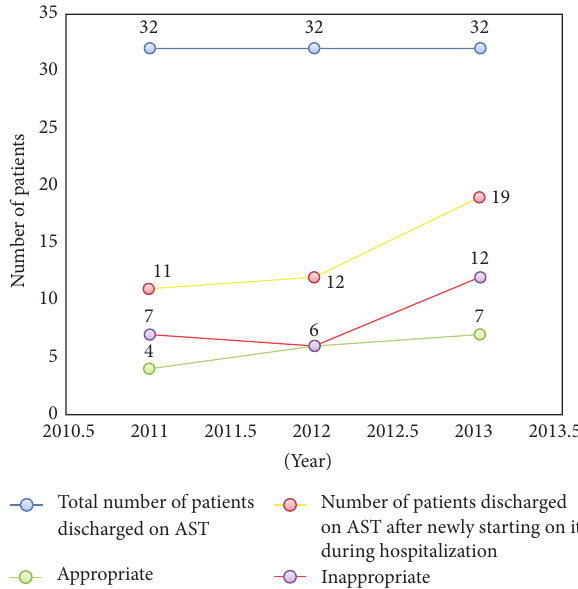
Figure 3: Consort diagram showing the AST prescribing pattern at a community hospital from January 2011 to December 2013. AST: acid suppressive